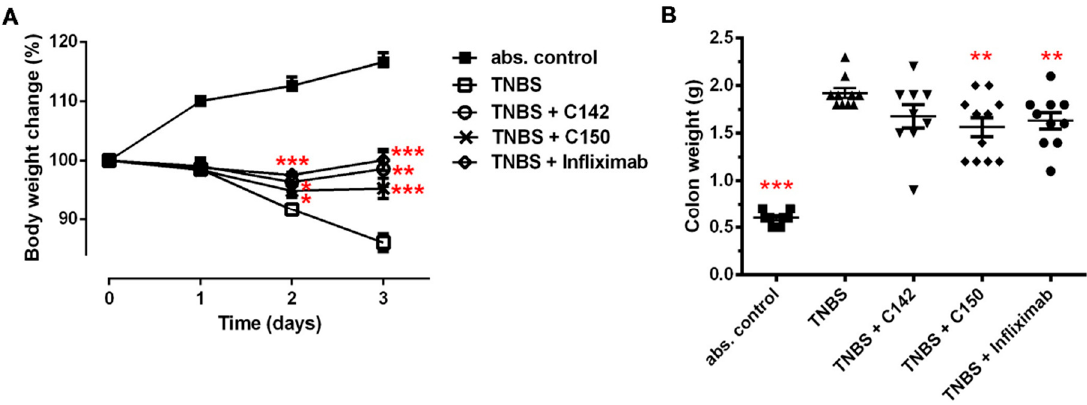
Figure 4. ( A ) Body weight change and ( B ) colon weight change in TNBS-induced colitis. Treatment with C142 or C150 rescued the loss of body weight and the degree of tissue oedema in the colon. Experimental design and treatments are described in Sections 4.2. and 4.3 in Materials and Methods. Results are shown as mean ± S.E.M.; n = 8–11; * p < 0.05, ** p < 0.01, *** p < 0.001 pair-wise comparison with TNBS-treated group.